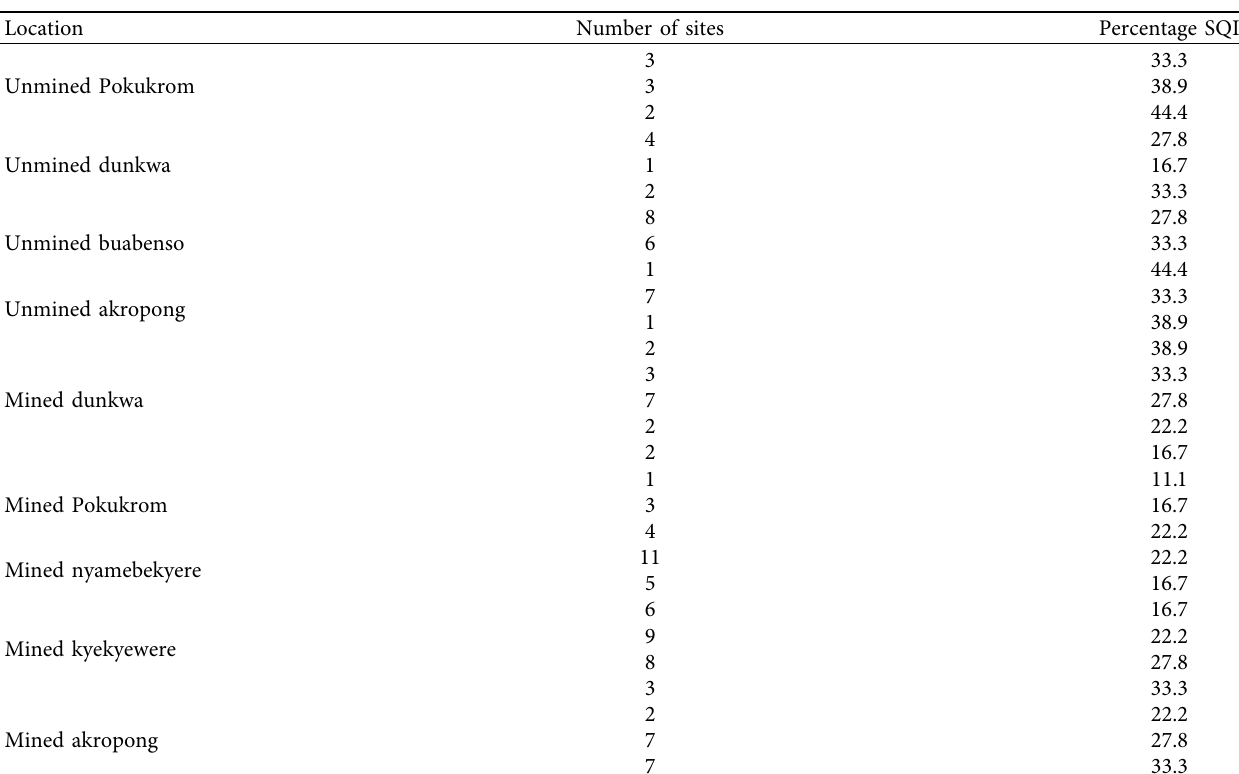
Table 6: Percentage SQI of unmined and mined soils.